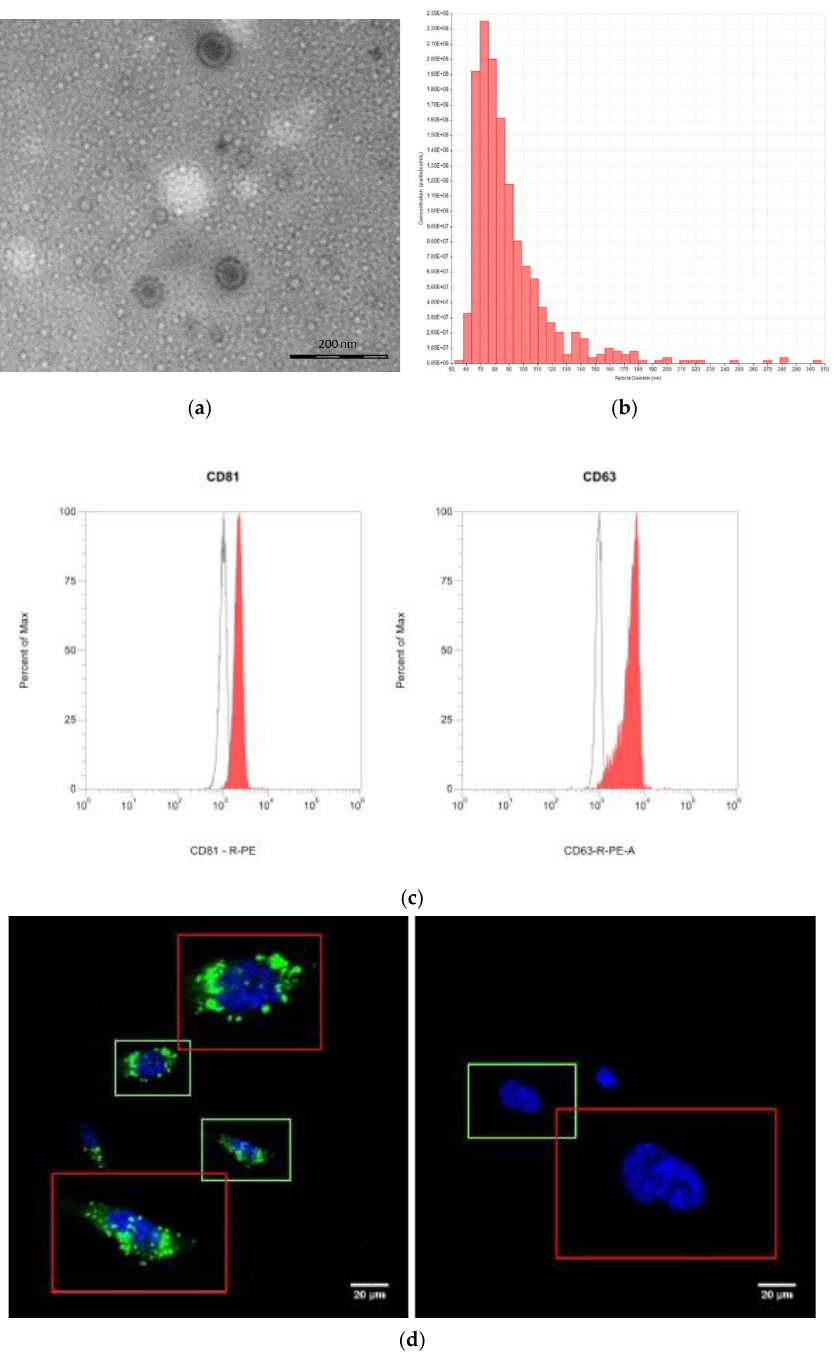
Figure 1. DFO-sEV production and HUVEC treatment. ( a ) Representative image of DFO-sEVs at TEM. sEVs appear with the typical bilayer cup-shaped membrane structure. ( b ) Particle size distribution and concentration of DFO-sEVs analyzed by tunable resistive pulse sensing: mean diameter of 90 ± 30.9 nm, mode of 73 nm, and particle size distribution of D10 67, D50 82, and D90 121. The average concentration was 1.33 × 10 9 particles/mL. ( c ) Flow cytometry of DFO- sEVs showing positivity to surface markers: CD81 and CD63 (DFO-sEVs in red, vehicle in gray). ( d ) Representative image of the uptake of PKH67-labeled green fluorescent DFO-sEVs (left) and of negative control, i.e., PKH67-labeled PBS, (right) after 24 h of incubation. Nuclei stained with Hoechst 33342 (blue). In red area, 2 × magnification of adjacent green